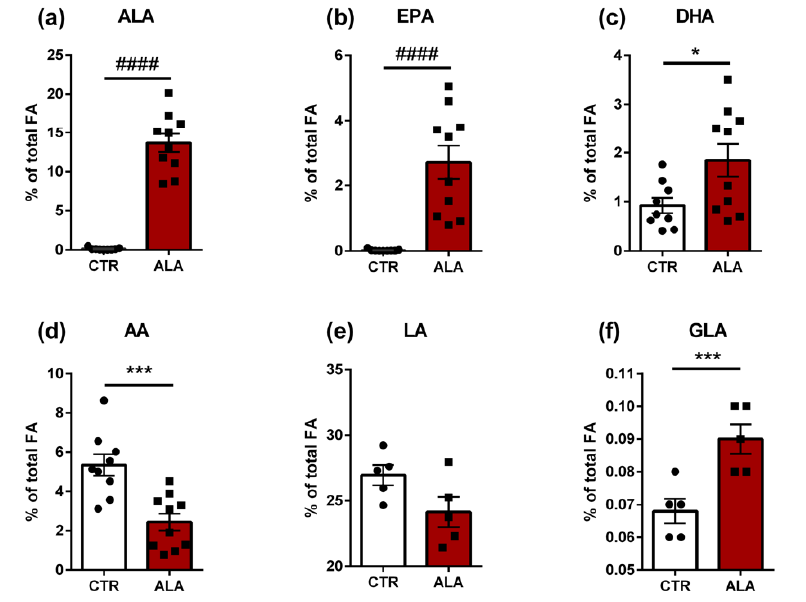
Figure 5. Impact of the ALA-rich diet on fatty acid composition of the mouse small intestine. Bar plots show mean values + standard error of the mean (SEM). n = 9 in control group, n = 10 in ALA group for ( a ) ALA, ( b ) EPA, ( c ) DHA and ( d ) AA. n = 5 per group for ( e ) LA and ( f ) GLA. #### p < 0.0001, Mann-Whitney test; *** p < 0.001, * p < 0.05, unpaired t -test. ALA: α-linolenic acid; AA: arachidonic acid; CTR: control diet;